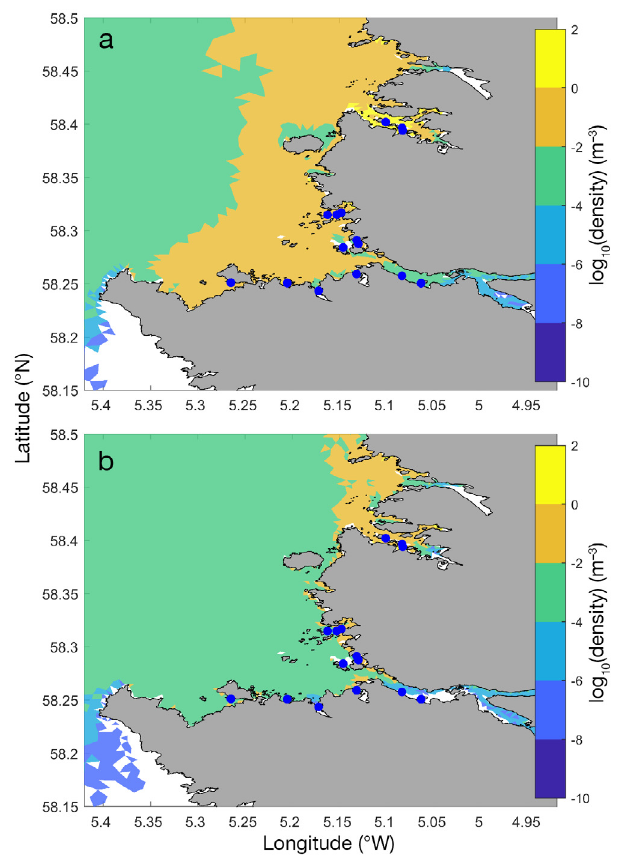
Fig. 5. Mean sea lice ( Lepeophtheirus salmonis) densities predicted by a biophysical model over the study period (June− December 2013): (a) juvenile (non-infective) lice and (b) copepodid (infective) lice. The model simulates the movement of passive surface-dwelling larvae released from fish farm locations (blue circles) on a continuous basis, weighted according to site stocked biomass of salmon and lice count (gravid female lice per fish). Variation over time is shown in an animation in Supplement